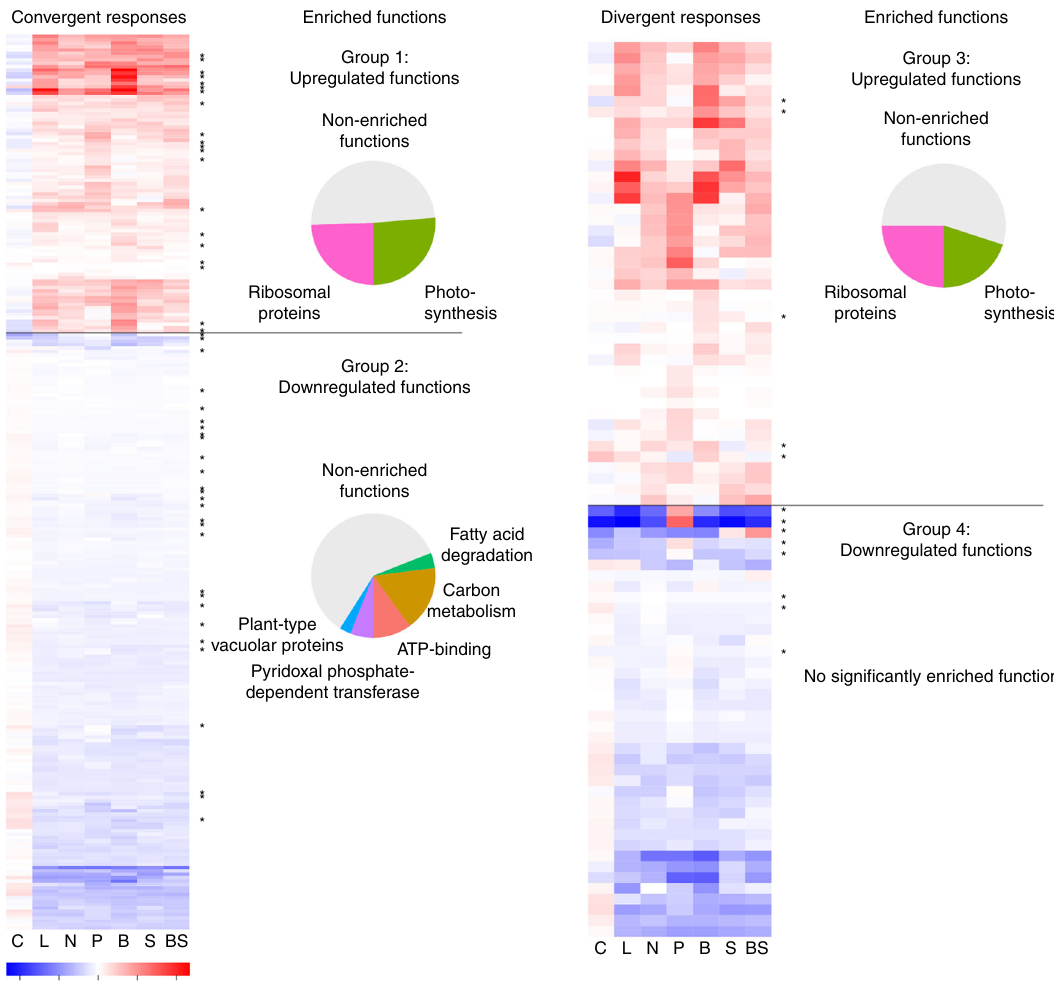
Fig. 3 Protein expression level heatmaps and annotation for the differentially expressed proteins. Both divergent and convergent responses were divided into upregulated and downregulated functions based on the mean expression level of each protein across the treatments (marked below the heat maps). Annotation from GO Biological Processes was available for 166 of 351 proteins. Positive convergent and divergent responses were signi fi cantly enriched in photosynthesis- and ribosome-related proteins (DAVID Functional Enrichment Analysis p < 0.01). Negative convergent responses were signi fi